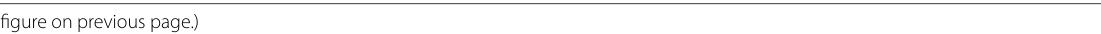
figure on previous Fig. 6 a Record sections covering an offset range of 750 km from OBS1–5 along the EW line. Reduction velocity is 8.5 km/s. b Record sections from OBS1, 2, and 5 along the NS1, NS2, and NS5 lines, respectively. Reduction velocity is 8.0 km/s. All observed waveforms were band-pass-filtered (5–20 Hz), and adjacent traces were stacked within an offset range of 200 m to improve the signal-to-noise ratio. The green, red, cyan, and yellow lines indicate the calculated travel times of P2, P3, Pt, and Pn, respectively. The dashed red line on the OBS1 record section along the EW line indicates the travel times of P3, which were calculated by using a velocity model without any decrease in crustal V